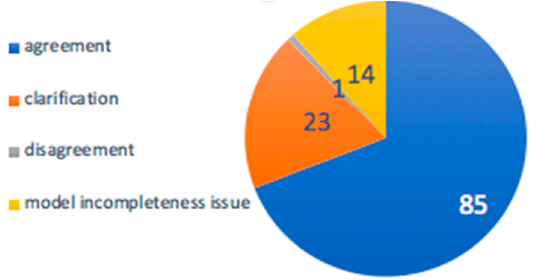
Figure 8. Metabolite annotations attained with PUMA against those identified by Roux et al. The blue slice represents “agreement”. The orange slice represents “clarification”. The gray slice represents “disagreement” and the yellow slice represents “model incompleteness issue”.